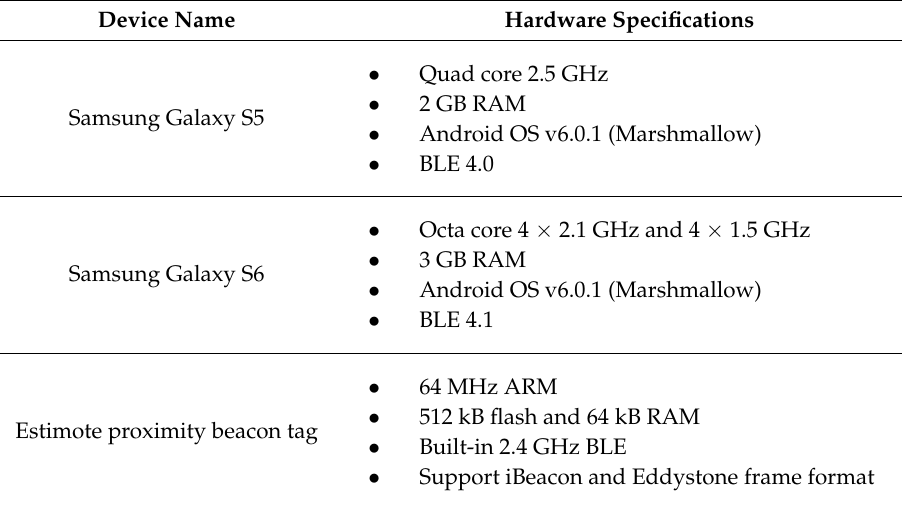
Table 2. Devices used to build the prototype.